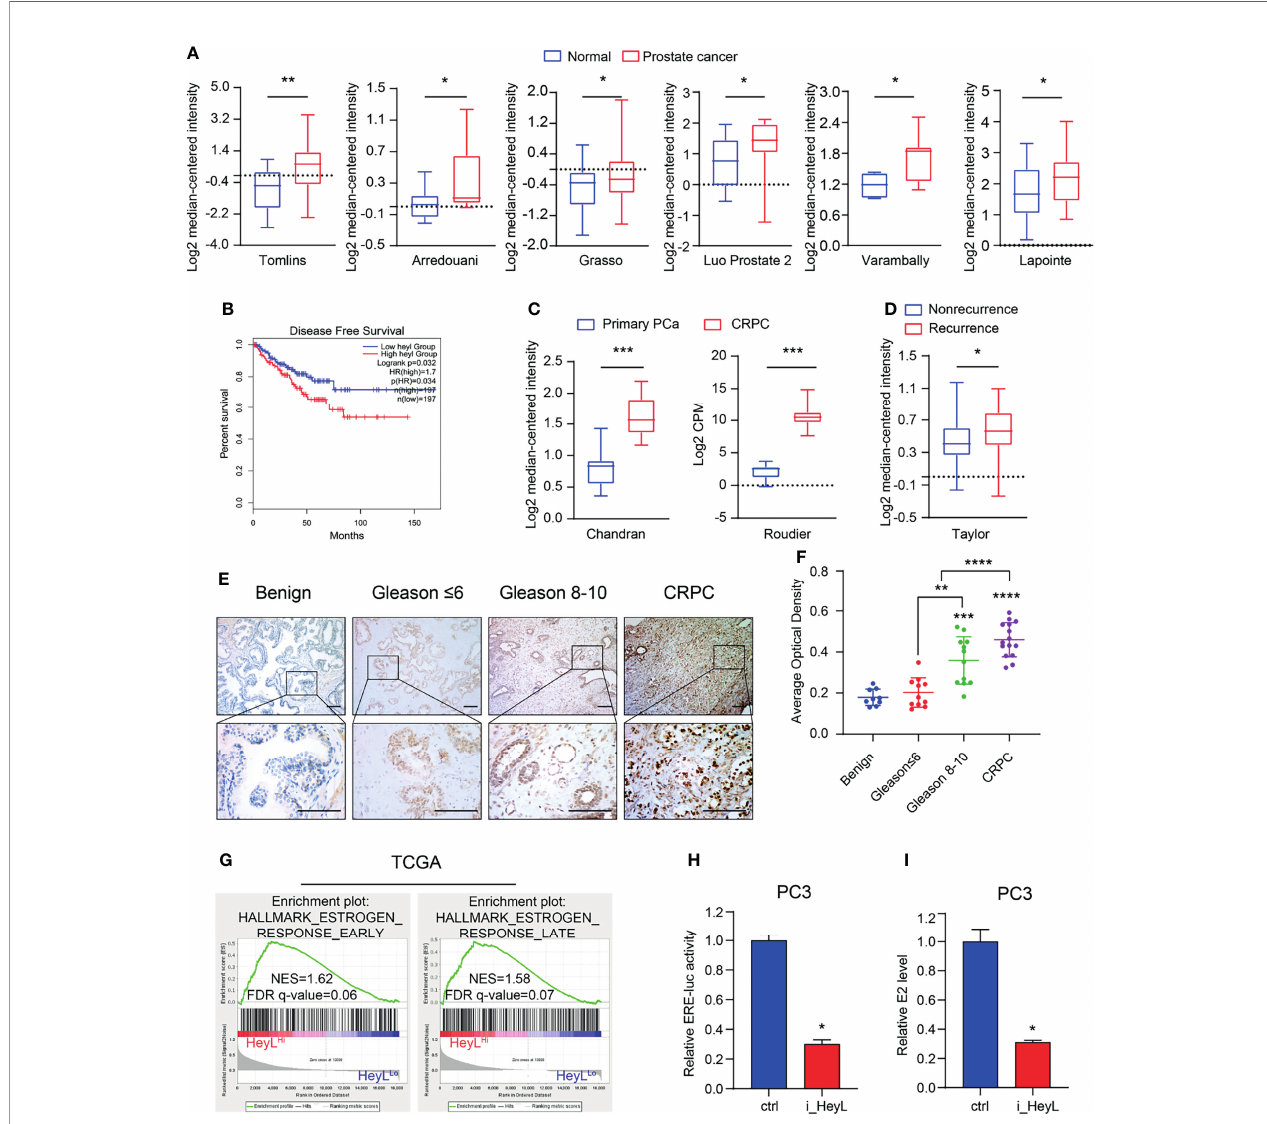
FIGURE 1 | HeyL overexpression is associated with poor prognosis and estrogenic effects in patients with CRPC. (A) HeyL mRNA levels in normal prostate and PCa tissues from 6 publicly available datasets (Tomlins, n(normal)=23, n(PCa=29); Arredouani, n(normal)=8, n(PCa=13); Grasso, n(normal)=28, n(PCa=59); Luo Prostate 2, n(normal)=15, n(PCa=15); Varambally, n(normal)=6, n(PCa=7); Lapointe, n(normal)=40, n(PCa=60)) (t-test). (B) Kaplan-Meier curve of disease-free survival differences according to the HeyL expression level based on a TCGA cohort. (C) HeyL mRNA expression in primary PCa and CRPC tissues from 2 publicly available datasets (Chandran, n(primary PCa)=10, n(CRPC=21); Roudier, n(primary PCa)=11, n(CRPC=45)) (t-test). (D) Comparison of HeyL mRNA expression between recurrent and nonrecurrent PCa (n(nonrecurrent)=104), n(recurrent)=36) (t-test). (E) Representative images of HeyL IHC staining in benign prostate (n=9), low Gleason score PCa (Gleason score ≤ 6, n=11), high Gleason score PCa (Gleason score 8-10, n=12), and CRPC tissues (n=15); scale bar: 100 µm. (F) Average optical density of HeyL in low Gleason score vs. high Gleason score tissues and in primary PCa (low Gleason score and high Gleason score) vs. CRPC tissues (t- test). (G) GSEA plot of the association between HeyL and the estrogen response gene set in the TCGA-PRAD dataset. (H, I) ER transcriptional activity (ERE-Luc) (H) and level of intracellular 17 b -estradiol (I) in control and HeyL knockdown PC3 cells. PRAD: prostate adenocarcinoma. The data are presented as the mean ± SD values (n=3). * p < 0.05, ** p < 0.01, *** p < 0.001, **** p <